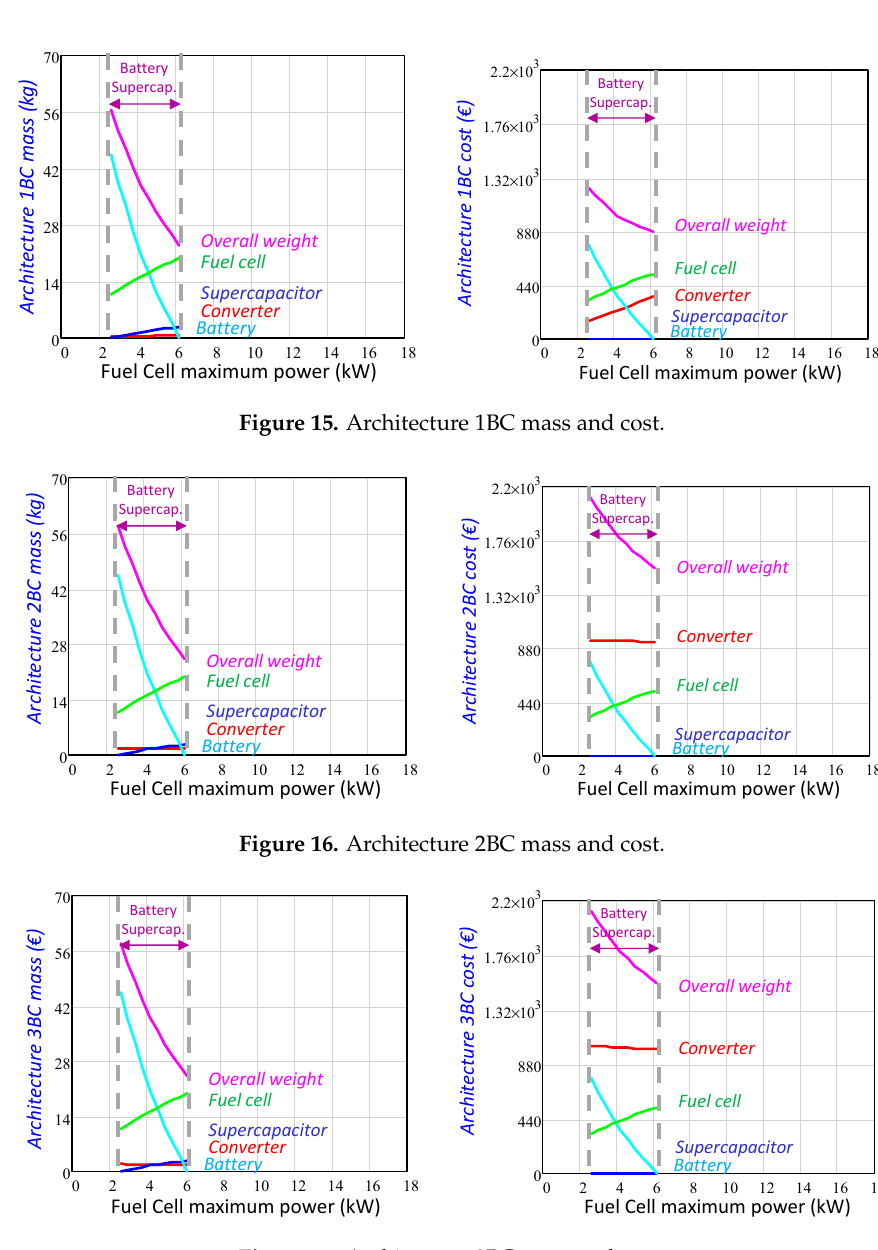
Figure 17. Architecture 3BC mass and cost.